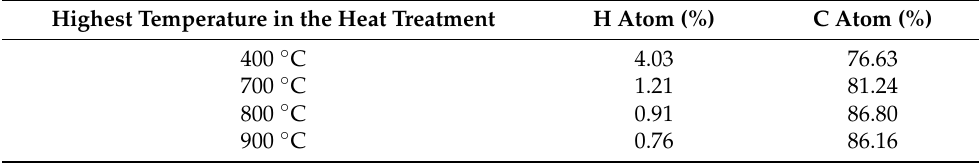
Table 2. CHN element analysis of MCF-As with the heat treatment up to different temperatures.